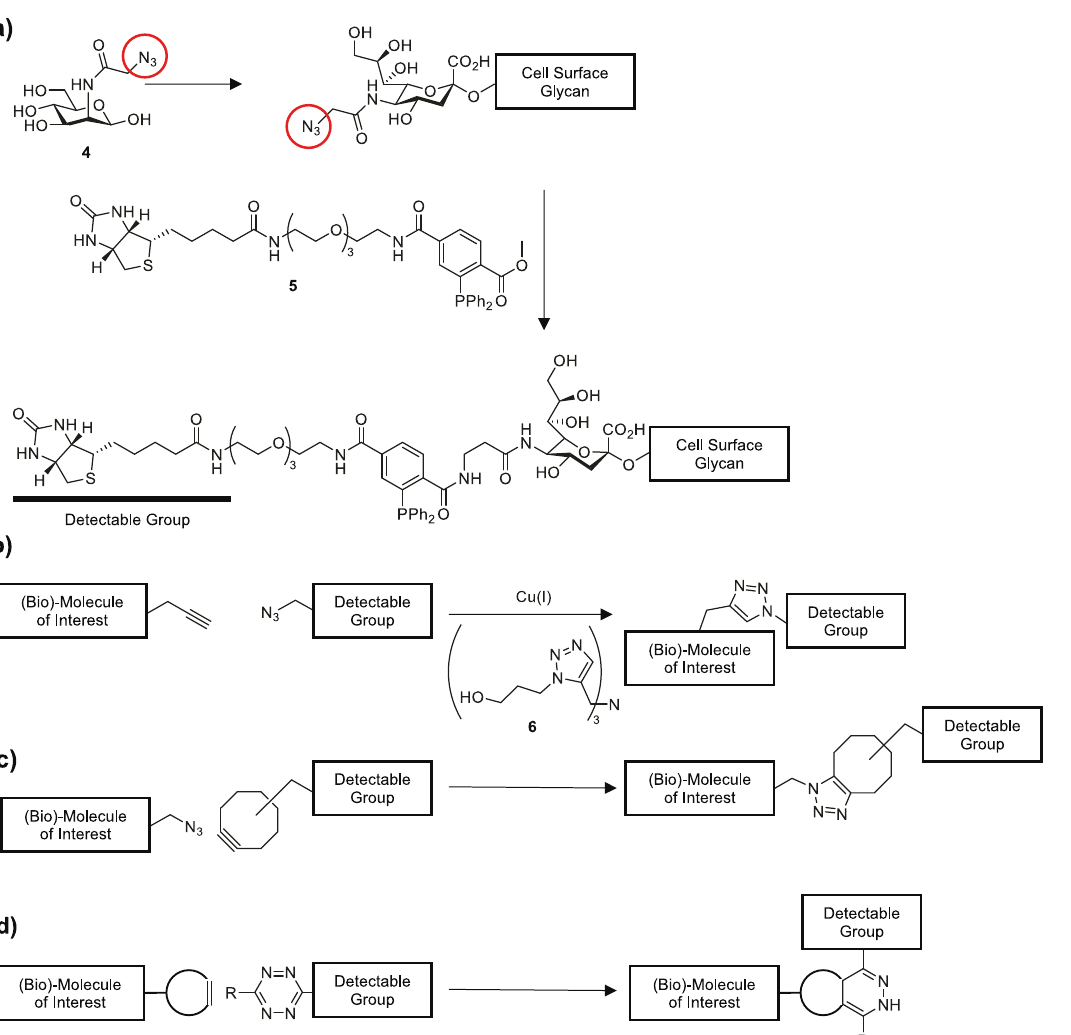
Fig. 2 Overview of copper catalyzed and live-cell compatible click reactions. a Metabolic glycan labeling: N-acetylmannosamine is modi fi ed with an azide group, circled in red, to give N-azidoacetylmannosamine 4. This modi fi cation is tolerated by all metabolic enzymes involved in the introduction of sialic acids on glycoproteins and glycolipids on the cell surface. The resulting azido-glycans were subsequently modi fi ed with biotin-phosphine reagent 5. This resulted in biotinylation of the sialic acids, allowing their on-surface quanti fi cation. b The copper- catalyzed click reaction between an alkyne and an azide to yield a 1,4-triazole is one of the lowest background bioorthogonal reactions. Unfortunately, the potential toxicity of the copper catalyst minimizes its use in live cells; c This was circumvented by adding ring strain to the alkyne reagent to give the strain-promoted alkyne-azide cycloaddition reaction. Here no catalyst is needed due to the increased reactivity of the alkyne; d The inverse electron-demand Diels-Alder reaction is an oft-used live-cell compatible reaction. The strained double bond can react with a tetrazine to form a dihydropyridazine ring between after